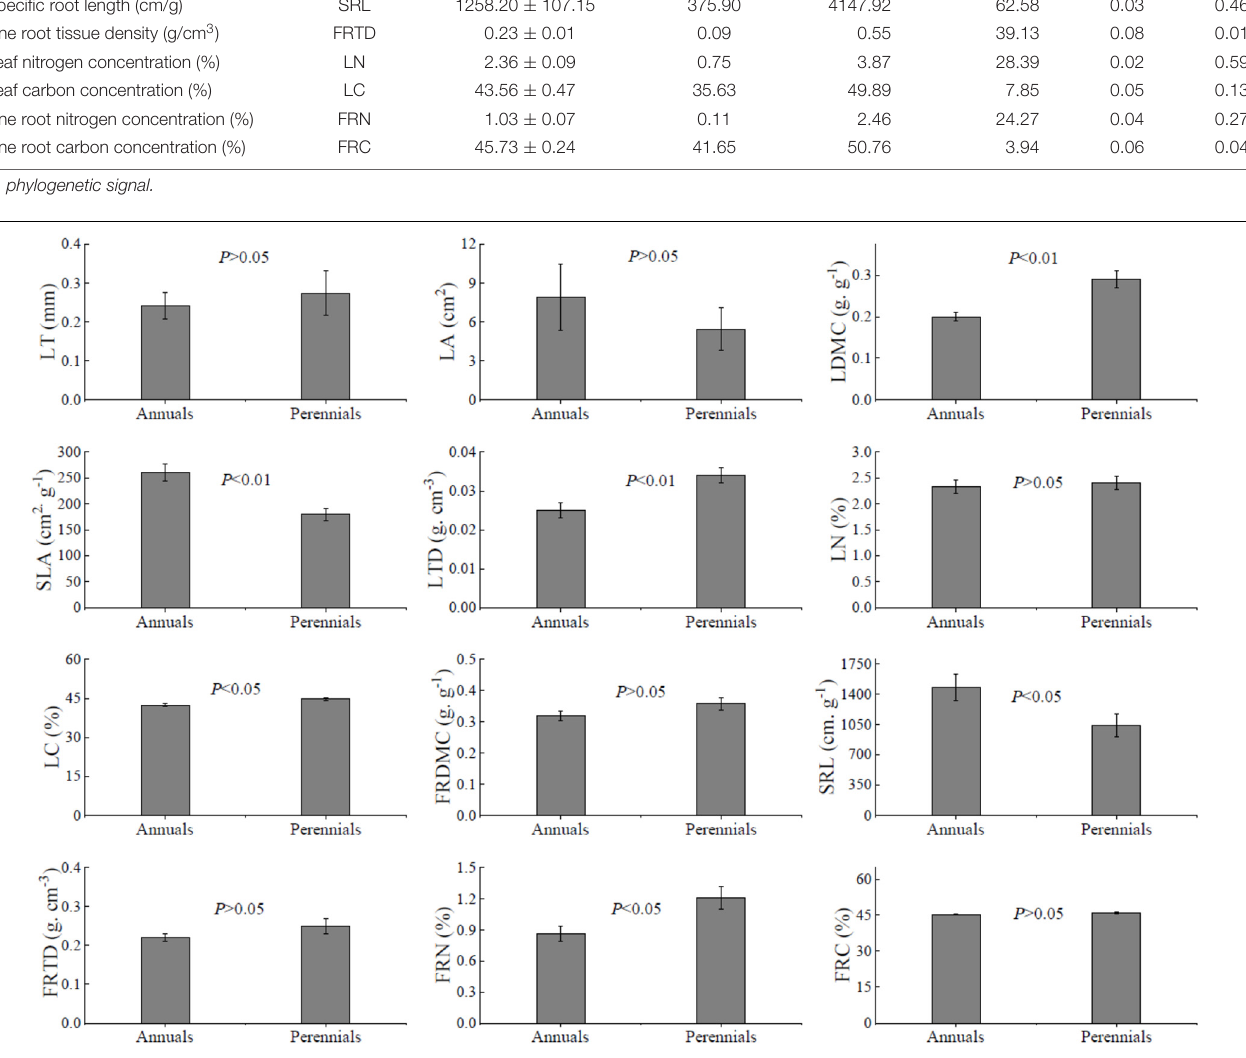
FIGURE 1 | Traits of leaf and fine root of 54 dominant species. LT, leaf thickness; LA, leaf area; LDMC, leaf dry-matter content; SLA, specific leaf area; LTD, leaf tissue density; FRDMC, fine root dry-matter content; SRL, specific root length; FRTD, fine root tissue density; LN, leaf nitrogen concentration; LC, leaf carbon concentration; FRN, fine root nitrogen concentration; FRC, fine root carbon concentration. Values are mean ± SE. Independent-sample t -test, P < 0.05 represents a significant difference between annuals and